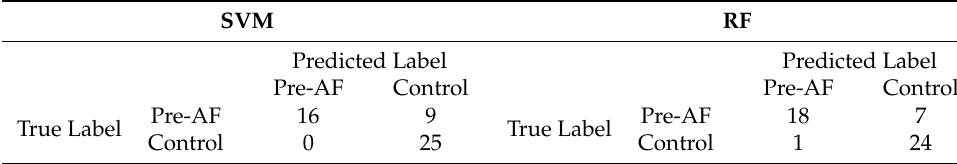
Table 5. Confusion matrix on the test data (2.5 min before onset).